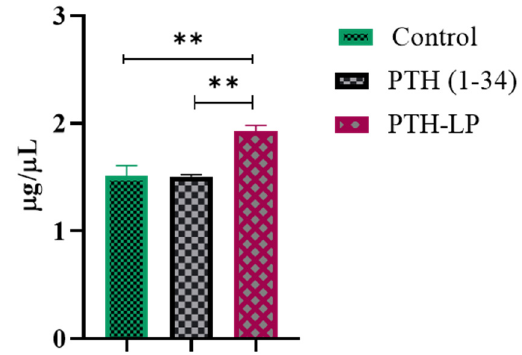
Figure 8. Calcium calorimetric assay. The results represent the means ± SDs ( n = 6). ** p < 0.01.